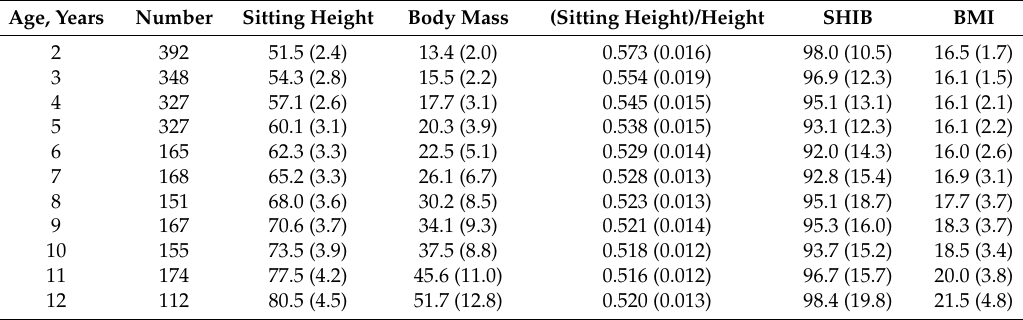
Table 2. Sample sizes and means (with standard deviations in brackets) of sitting height (cm), body mass (kg), ratio of sitting height to standing height, sitting-height index of build (SHIB, kg/m 3 ) and body mass index (BMI, kg/m 2 ) of white females. The data are from the NHANES III laboratory data file